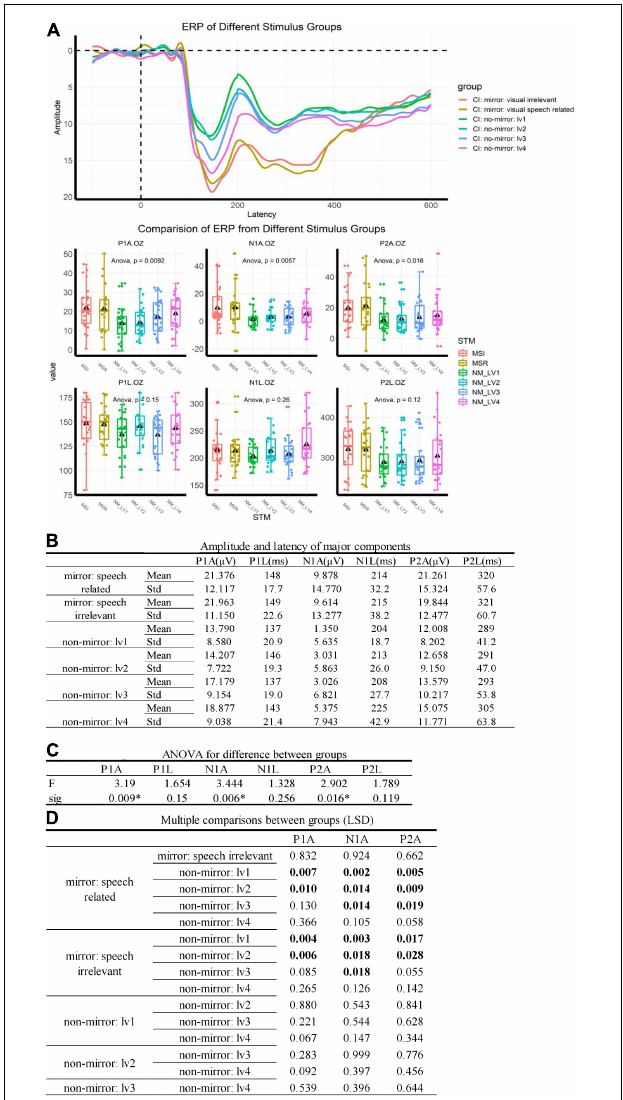
FIGURE 1 | ERP results. (A) ERP traces for the different groups. Stimuli were delivered at 0 ms, and a P1–N1–P2 complex was observed after 100 ms. MVSR: mirror and visual speech-related, MVSI: mirror and visual speech-irrelevant, NM: no-mirror. Delta: mean value. (B) Values used to describe ERP components. (C) An ANOVA showed that the difference between groups was mainly caused by differences in ERP amplitudes. ∗ p < 0.05. (D) Multiple comparisons post-ANOVA. “Boldface number” means p < 0.05, indicating that significant differences in the ANOVA were mainly caused by the difference between the mirror stimulus group (including speech-related mirror stimuli and speech-irrelevant stimuli) and the non-mirror stimulus group (including the four types of non-mirror